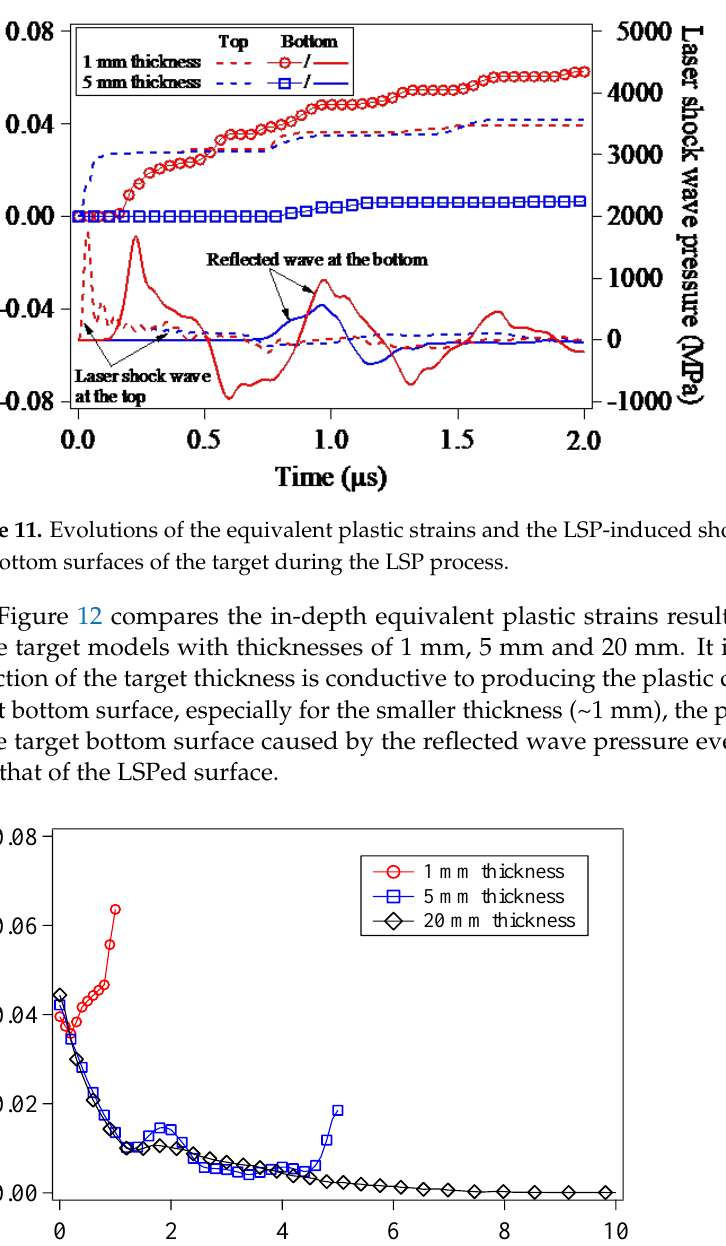
Figure 12. In − depth equivalent plastic strains of the LSPed targets with different thicknesses. Depending on the plastic deformations caused by the LSP-induced shock wave and its reflected wave, the in-depth residual stresses resulting from the recovery of the elastic deformations surrounding the plastically-deformed zone are shown in Figure 13. For the 1 mm-thickness target model of pure Al, the compressive residual stresses closing to the target bottom surface are larger than that closing to the LSPed surface. However, the distribution of the in-depth residual stresses resulting from the finite element simulation of LSP of the 5 mm-thickness target model is much similar to the results of LSP of the 20 mm- thickness target model, although the maximum compressive residual stress is closing to the target bottom surface, which is different from that of the 20 mm-thickness target model. The reason could be explained that the smaller plastic deformations at the bottom of the 5 mm-thickness target model, as shown in Figure 11, may have not made a big difference in the in-depth residual stresses induced by